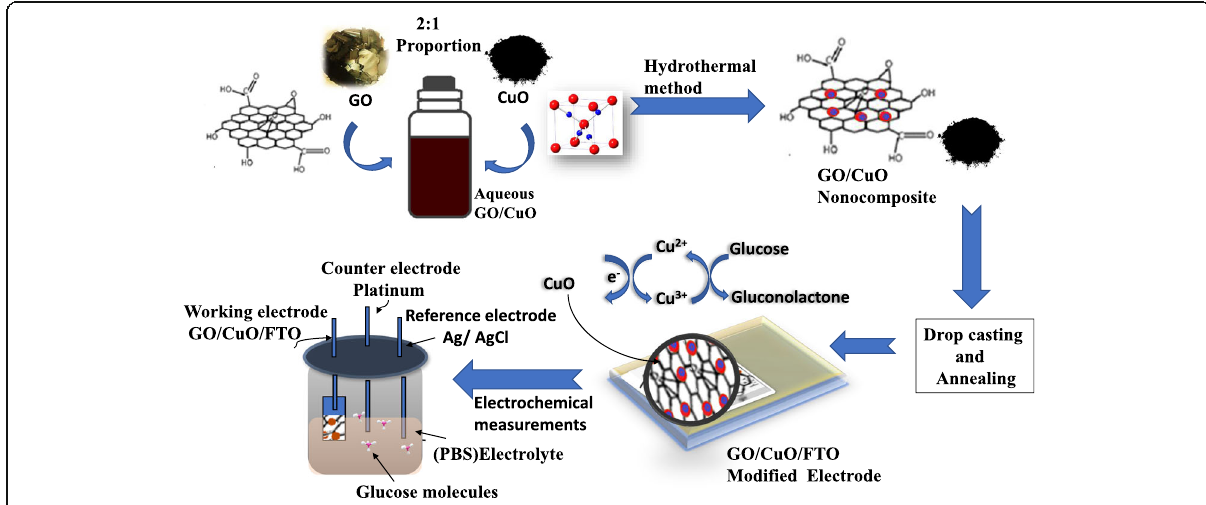
Fig. 1 Glucose sensing mechanism of GO/CuO/FTO electrode